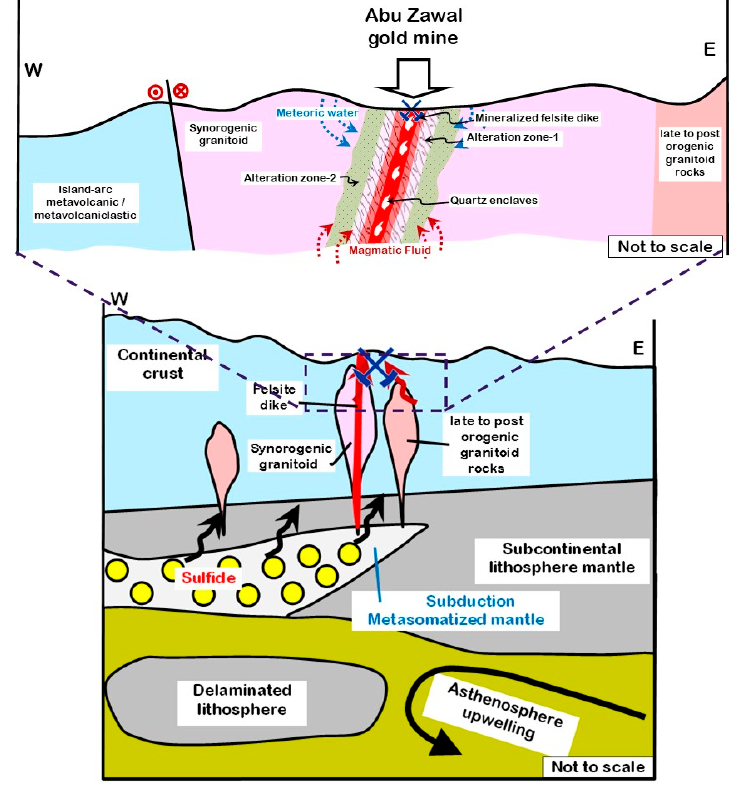
Figure 17. Simplified sketch cross section showing the magmatic-metasomatic processes at the Abu Zawal (Fatira) gold mine.